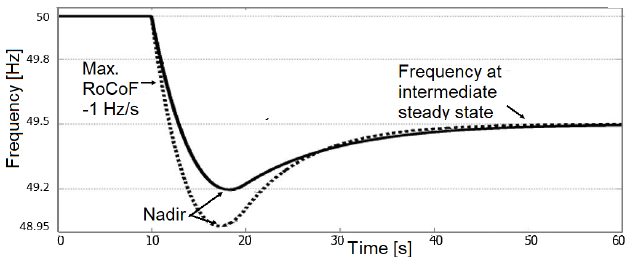
Figure 2. Basic frequency response and limits for the Gran Canaria electrical